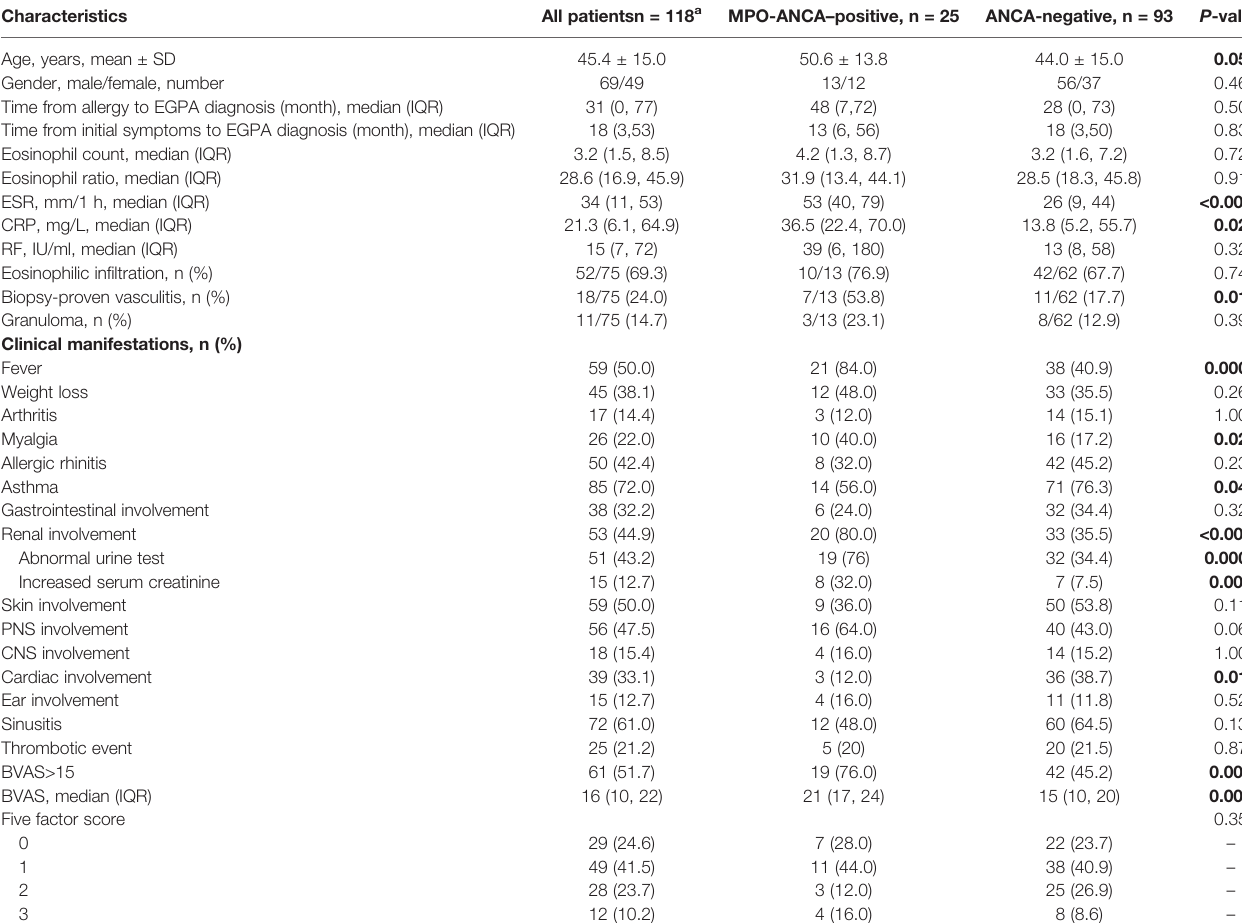
TABLE 1 | Clinical features of patients with EGPA with MPO-ANCA and without ANCA at baseline. Characteristics All patientsn = 118